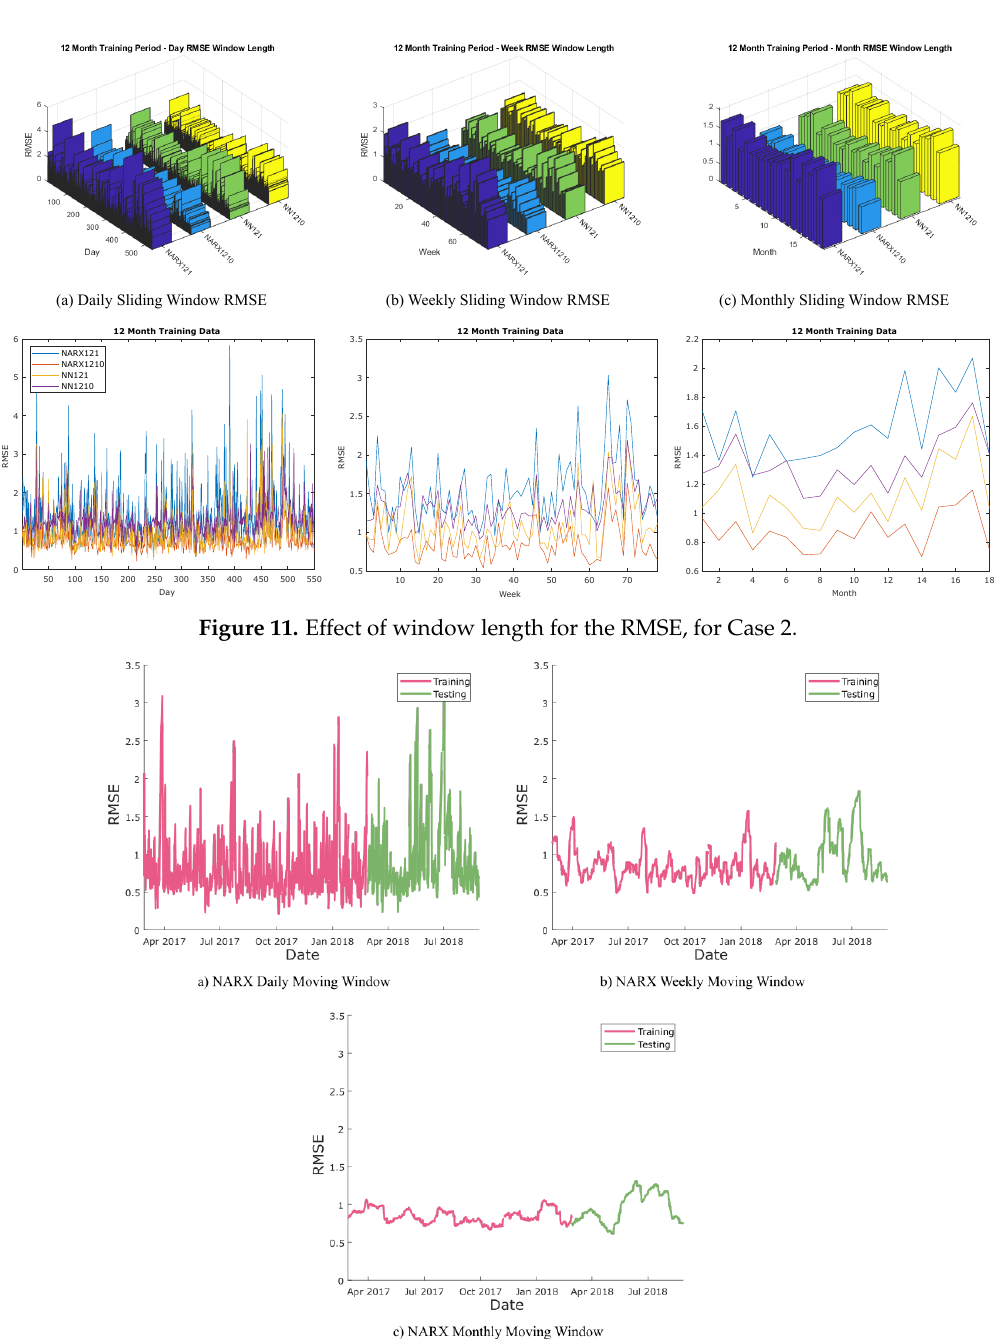
Figure 12. Effect of window length for Moving RMSE for NARX model with 12 month training period and 10 min time resolution, for Case